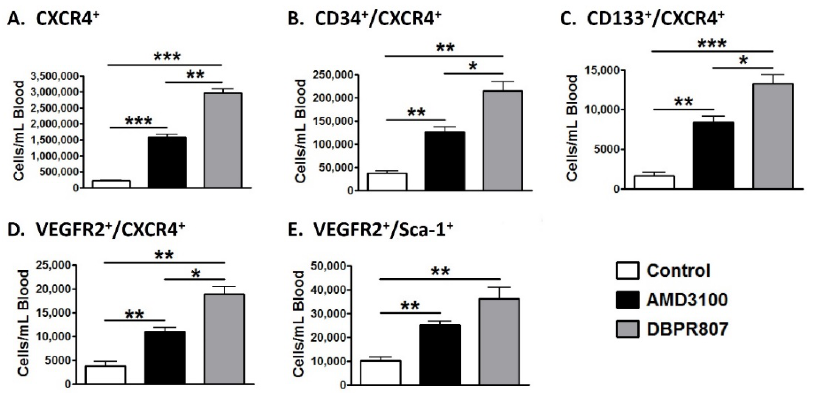
Figure 2. Various stem/progenitor cells were mobilized by DBPR807. Mice were subcutaneously injected with vehicle AMD3100 (6 mg/kg) or DBPR807 (20 mg/kg). At 2 h after dosing, the blood was harvested for analyzing the cell types of interest: ( A ) CXCR4 + cells, ( B ) CD34 + /CXCR4 + cells, ( C ) CD133 + /CXCR4 + cells, ( D ) VEGFR2 + /CXCR4 + cells and ( E ) VEGFR2 + /Sca-1 + cells. The data are presented as mean ± SEM ( n = 3 per group). Statistical analysis was performed by t -test: * p < 0.05, ** p < 0.01 and *** p < 0.001.